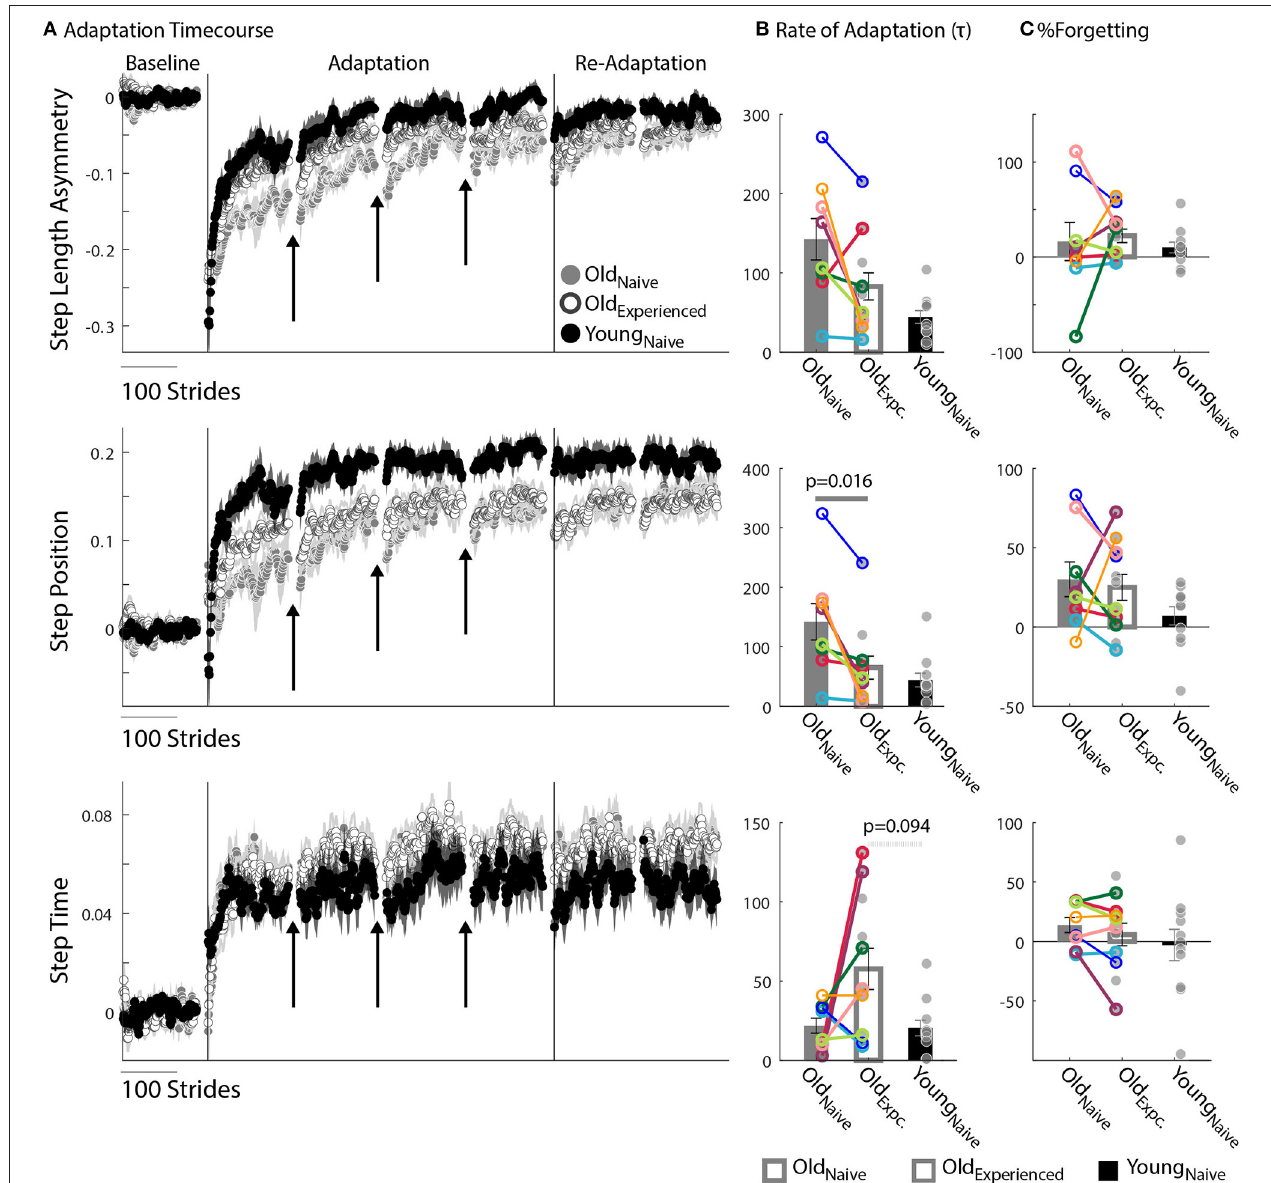
FIGURE 2 | Motor Adaptation. (A) Stride-by-stride timecourses of Baseline and Adaptation for StepAsym, StepPosition, and StepTime are illustrated. Black arrows indicate the resting breaks used to compute %Forgetting. Note the decay in the subjects’ adapted state that occurs due to the passage of time during the resting breaks. Dots represent the average of 5 consecutive strides and colored shaded regions indicate the standard error for each group. (B,C) Bar plots indicate the group’s average value ± standard errors. Individual subject behavior is indicated with dots. Dots edged and connected with colored lines ( n = 8) indicate paired data from the Old nave and Old experienced testing sessions that were used for statistical testing to determine the effect of exposure. Gray dots ( n = 11) indicate unpaired data from the Old experienced and Young nave groups that were used for statistical testing to determine the differences (or lack thereof) between experienced, older adults and naïve, younger adults. (B) Rate of Adaptation ( τ ): Recall that a larger τ means slower adaptation. The spatial Rate of Adaptation was reduced with exposure. In other words, older adults adapted faster when they had previously experienced the split-belt task compared to when they were naïve. The Rate of Adaptation was not different between the Old experienced and Young nave adults. (C) %Forgetting: Recall that large positive values of %Forgetting indicated that subjects’ motor states decayed during the resting breaks. Note that there are no age-related differences between groups when the duration of resting breaks was the same between younger and older groups.